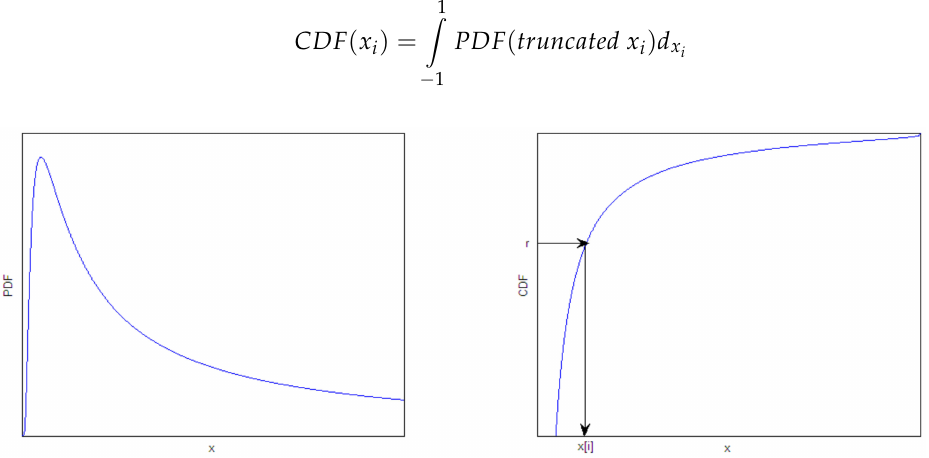
Figure 1. Sampling Mechanism for Real-Valued